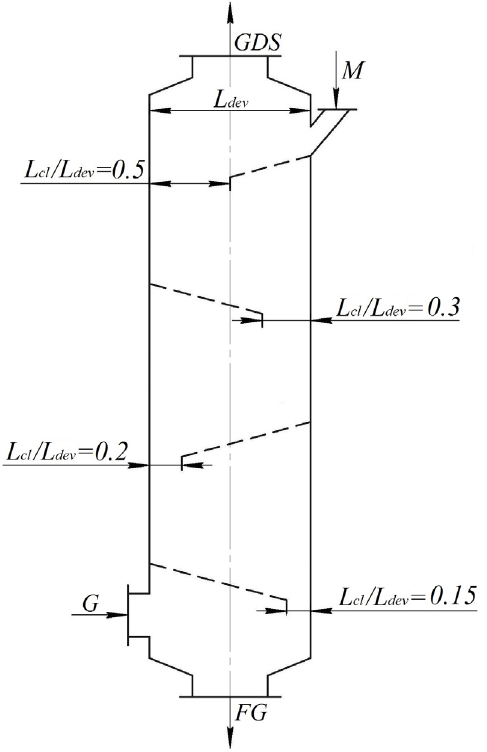
Figure 1. Multistage shelf device circuit: M —raw material; G —gas; GDS —gas-dispersed substance; FG —finished granules.